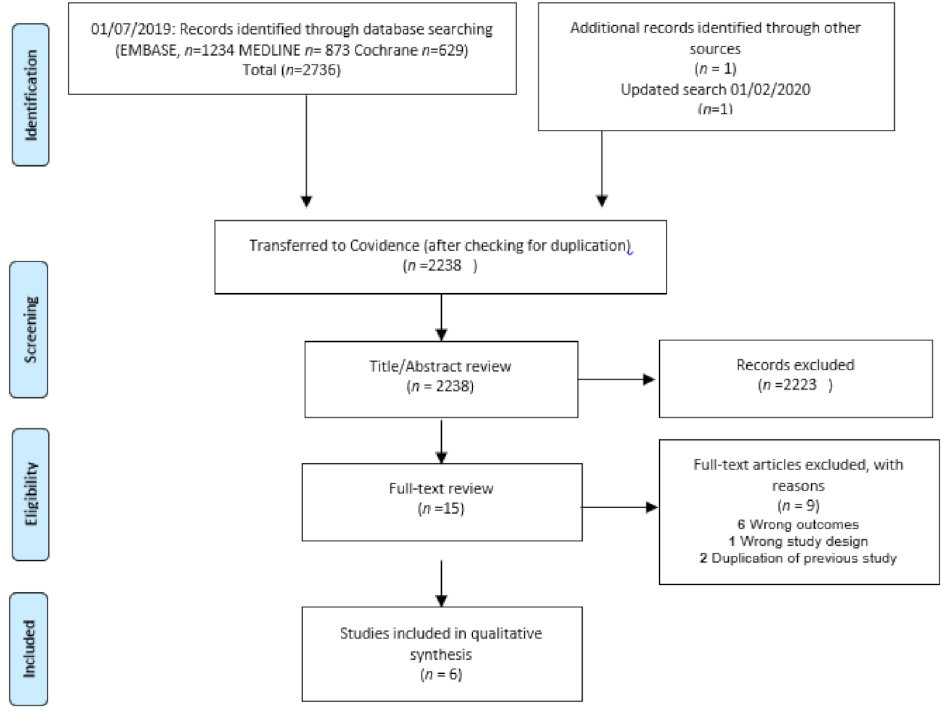
Figure 1. Study flow